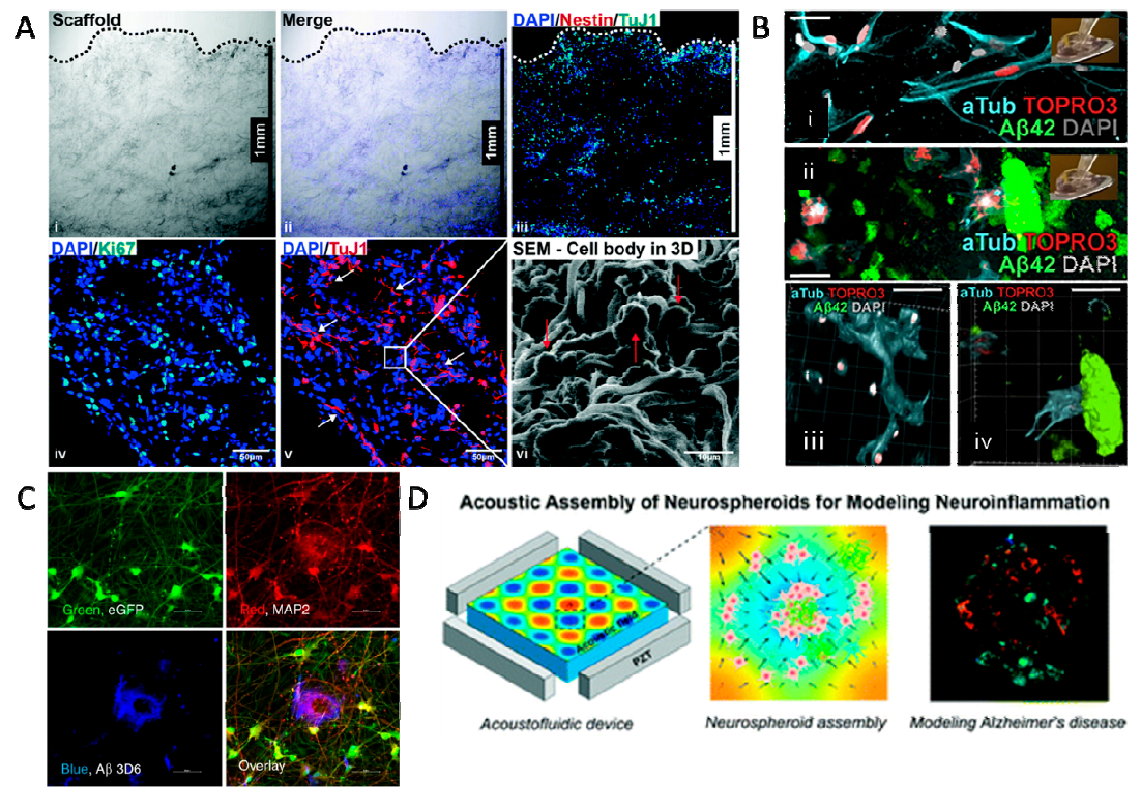
Figure 2. 3D in vitro models of Alzheimer’s disease. ( A ) PLGA scaffold encapsulating iPSC-derived NPCs, shown by proliferation marker Ki67, undifferentiated cell marker Nestin, and neural differentiation marker TuJ1. (i–iii) Cross-section ofthe 3D microfiber scaffold showing cell infiltration, distribution and differentiation. (iv,v) cell proliferation and differentiation. (vi) SEM image of the scaffold cross-section. Reprinted with permission from [134]. Copyright 2020, The Royal Society of Chemistry. ( B ) Reduction of neural plasticity in neural stem cells as a result of A β plaques. Image (i,iii) indicate healthy neural stem cells, which can form new synaptic connections, shown in (iii). Image (ii,iv) have the A β plaques incorporated in the hydrogel and are unable to form new synaptic connections. Reprinted with permission from [135]. Copyright 2018, Elsevier. ( C ) 3D spheroids derived from human neural progenitor cells, displaying A β pathology (shown in blue). Green and Red channels depict the neuronal cells and differentiated neurons, respectively. Reprinted from [138]. Copyright 2020, Nature Portfolio. ( D ) Acoustofluidic platform to assemble cells and A β oligomers into neuro-spheroids representing AD. Reproduced with permission of The Royal Society of Chemistry [139]. (i) cross-section of the 3D microfiber scaffold after sectioning (dotted line indicates the top surface of the 3D scaffold); (ii, iii) cell infiltration, distribution and differentiation of iPSC-derived NPCs (8529 cell line) inside the 3D scaffold as assessed via staining for TuJ1 (green) and Nestin (red) markers on D13; (iv) cell proliferation assessed by the Ki67 (green) marker and (v) cell differentiation with neurite formation indicated by the TuJ1 (red) marker of hESC-derived NPCs on D13; nuclei were counterstained with DAPI (blue); (vi) SEM image of the scaffold cross-section showing cell morphology and attachment on microfibers at 2000× magnification.